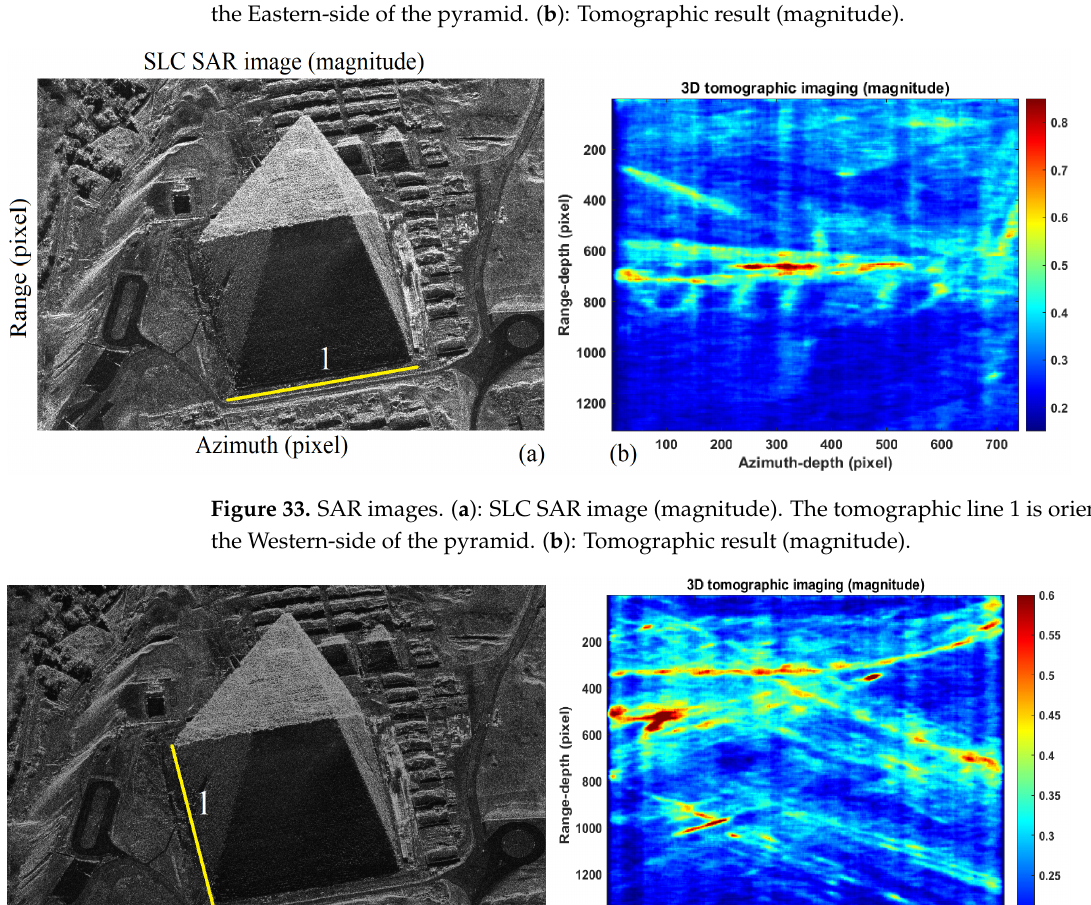
Figure 32. SAR images. ( a ): SLC SAR image (magnitude). The tomographic line 1 is oriented along the Eastern-side of the pyramid. ( b ): Tomographic result (magnitude).